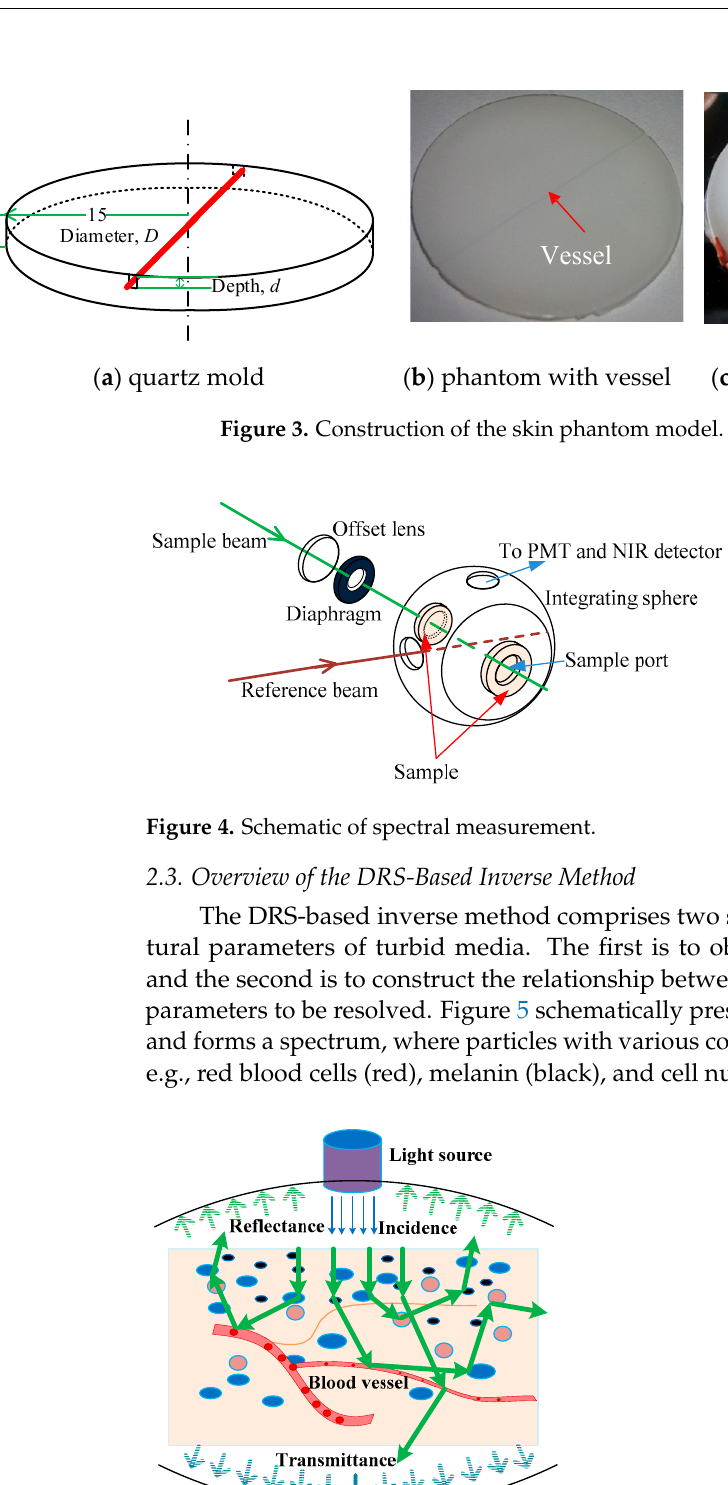
Figure 5. Schematic of light – tissue interaction.